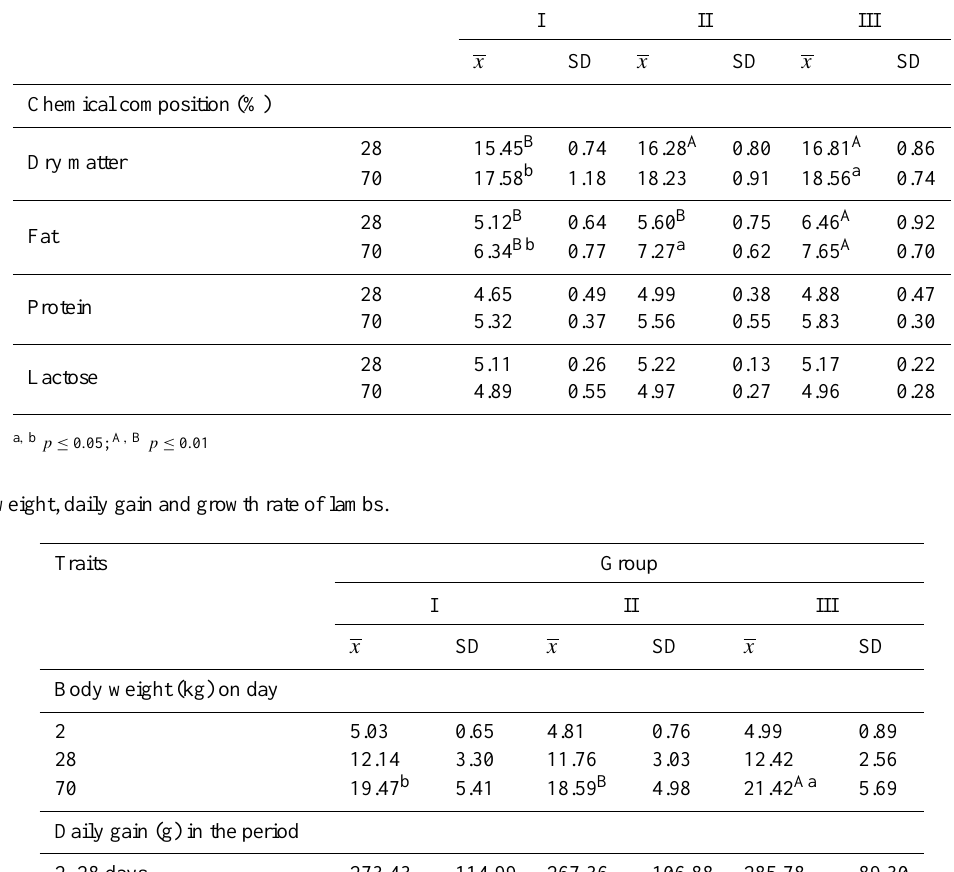
Chemical composition (%)